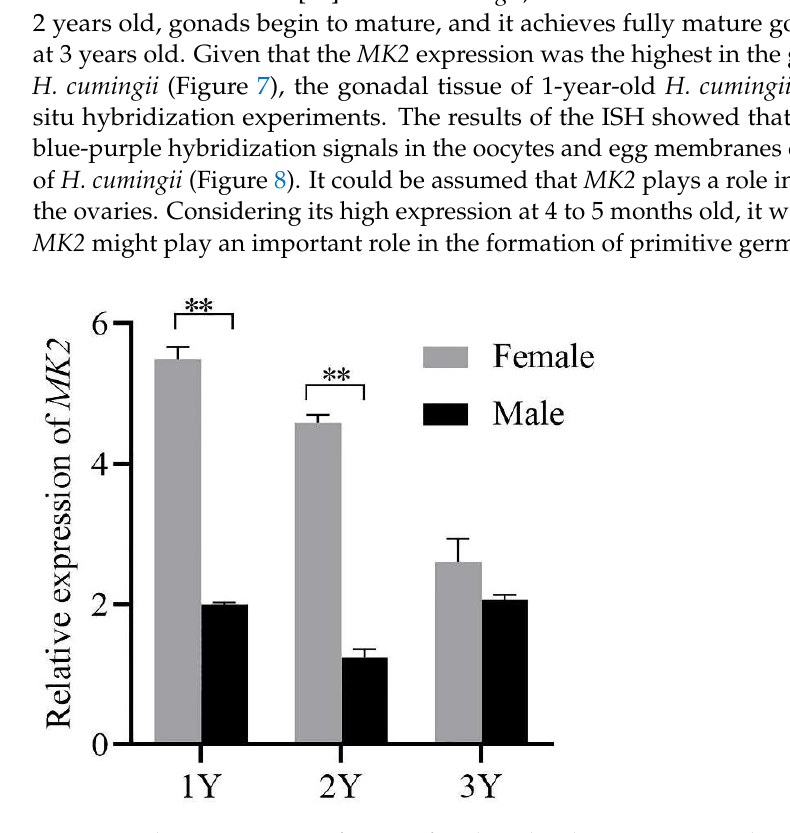
Figure 8. Relative expression of MK2 in female and male H. cumingii aged 1 to 3 years old. EF1α was selected as the internal reference gene, and the quantitative results all had three sets of biological replicates. The horizontal axis of the coordinates was the age of the H. cumingii (Y: years), and the vertical axis is the relative expression of MK2 . The analysis of significance was marked with an asterisk. Double asterisks mean a highly significant difference (** p < 0.01).